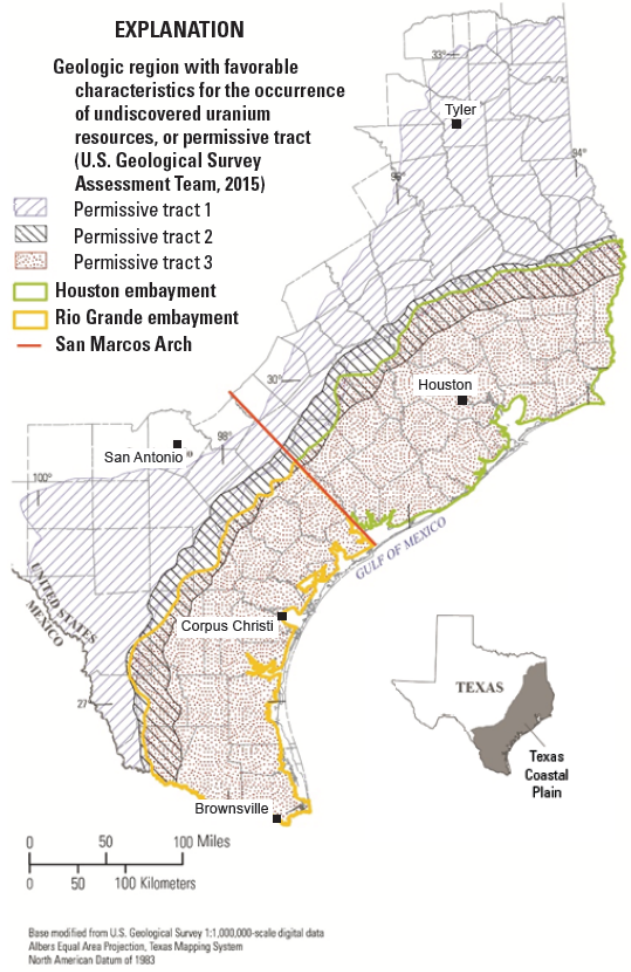
Figure 1. Map depicting the Texas Coastal Plain, and the three geologic regions, or tracts, that are referred to as “permissive” because of their perceived favorable characteristics for the occurrence of undiscovered uranium resources as delineated by [1], and the Rio Grande and Houston embayments separated by the San Marcos arch. The three permissive tracts are delineated based on the extents of selected geologic units in the Texas Coastal Plain: permissive tract 1 contains the Eocene-age Claiborne and Jackson Groups, permissive tract 2 contains the Oligocene-age Catahoula Formation and Miocene-age Oakville Sandstone, and permissive tract 3 contains the Pliocene-age Goliad Sand and Pleistocene-age Willis Sand and Lissie Formation.